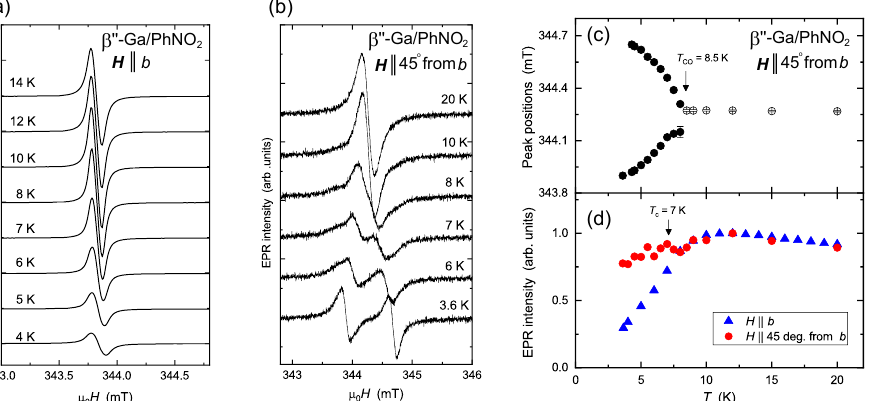
Figure 8. Temperature dependence of EPR spectra in b -axis field ( a ) and 45 ◦ field ( b ) [53]. No spectrum splitting was observed in b -axis field, whereas clear spectrum splitting was observed in 45 ◦ field below T CO = 8.5 K. The EPR intensity decreases in b -axis field below T c (cid:39) 7 K, but finite intensity was observed even at 4 K. ( c ) EPR peak position for 45 ◦ field determined by Lorentzian fit. ( d ) Temperature dependence of EPR intensity normalized at 12